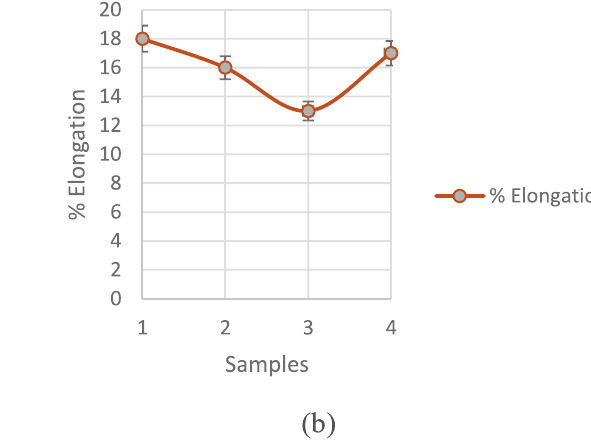
Fig. 14. (a) Strength and (b) % Elongation of the casting specimens.